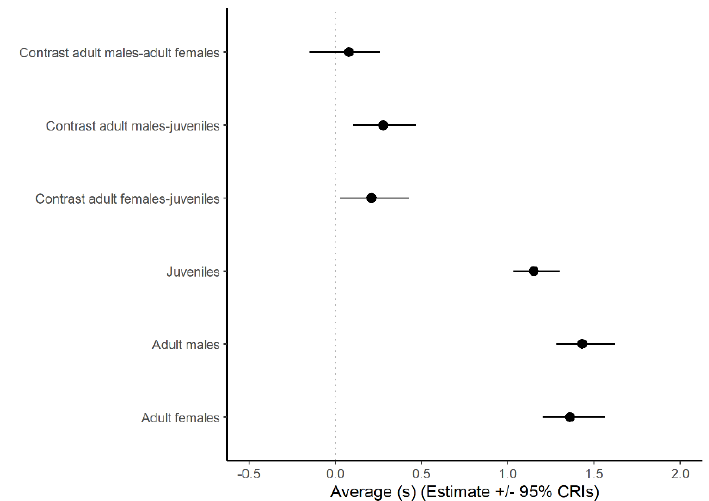
Figure 4. Average look duration (±95% credible intervals) predicted by a generalized linear mixed model implemented using a Bayesian framework with log-normal error distribution for three different classes of Florida scrub-jay sentinels: juveniles, adult males, and adult females. The value of 0 is shown with a vertical line. The average group size was set at four for the calculations.